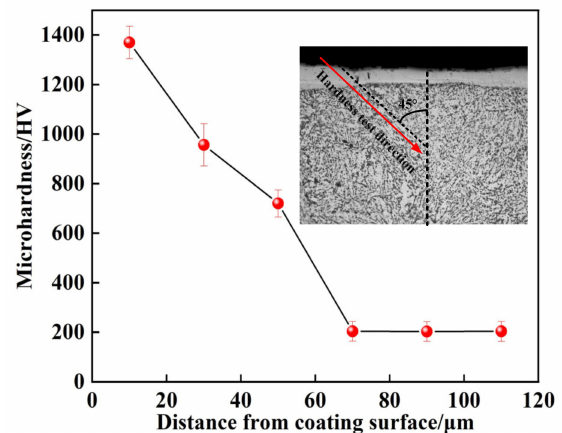
Figure 16. Hardness distribution of coating fabricated under 1000 W/350 Hz/(3 min/cm 2